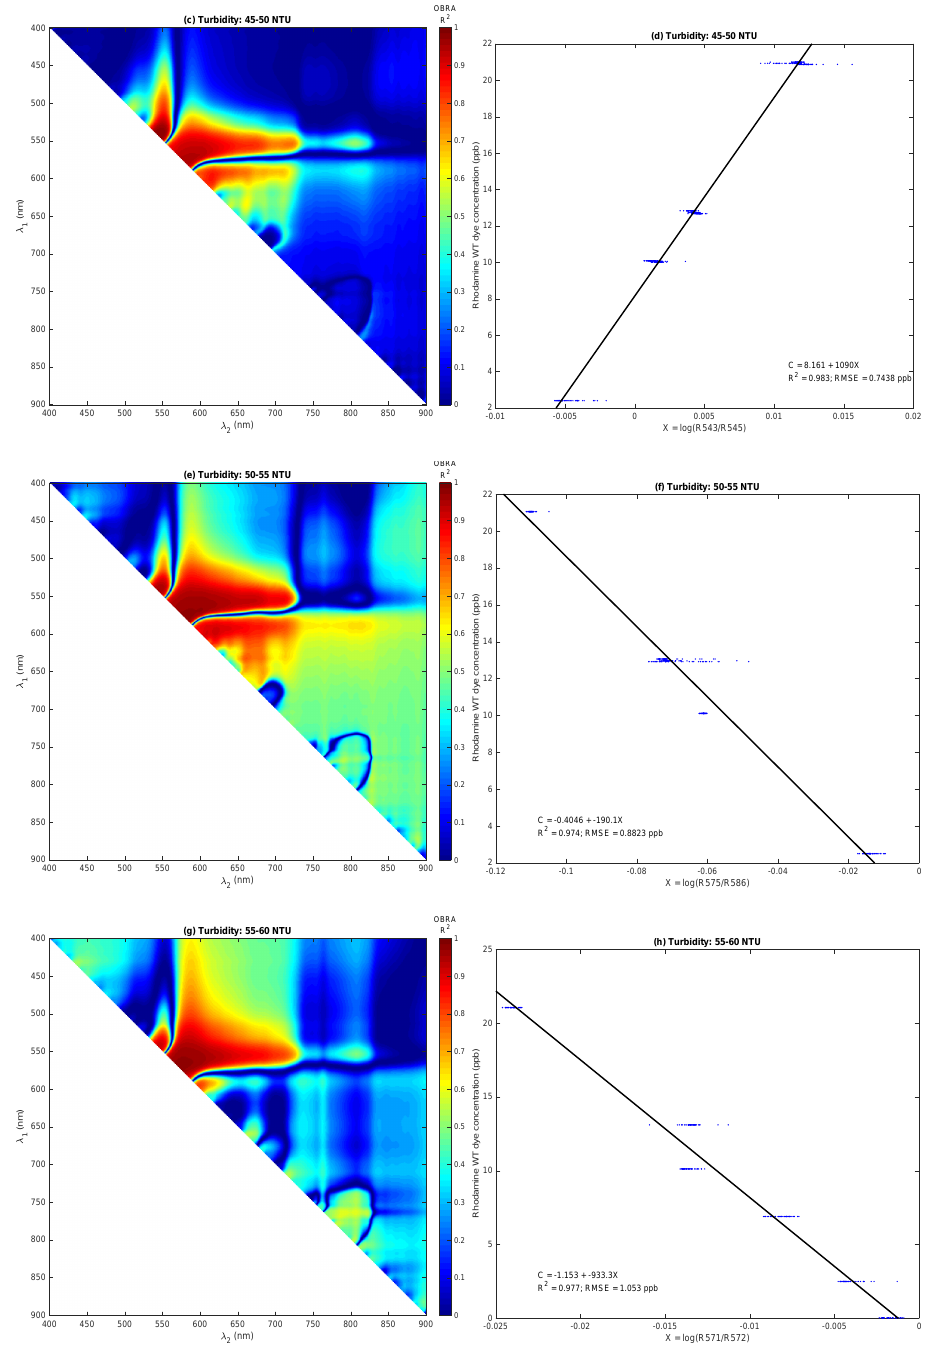
Figure 4. OBRA of field spectra stratified by turbidity range. The OBRA matrices in panels ( a , c , e , g ) illustrate spectral variations in the strength of the relationship between the spectrally based quantity X and dye concentration C . The calibration scatter plots and regression results for the corresponding optimal band ratios are shown in panels ( b , d , f , h